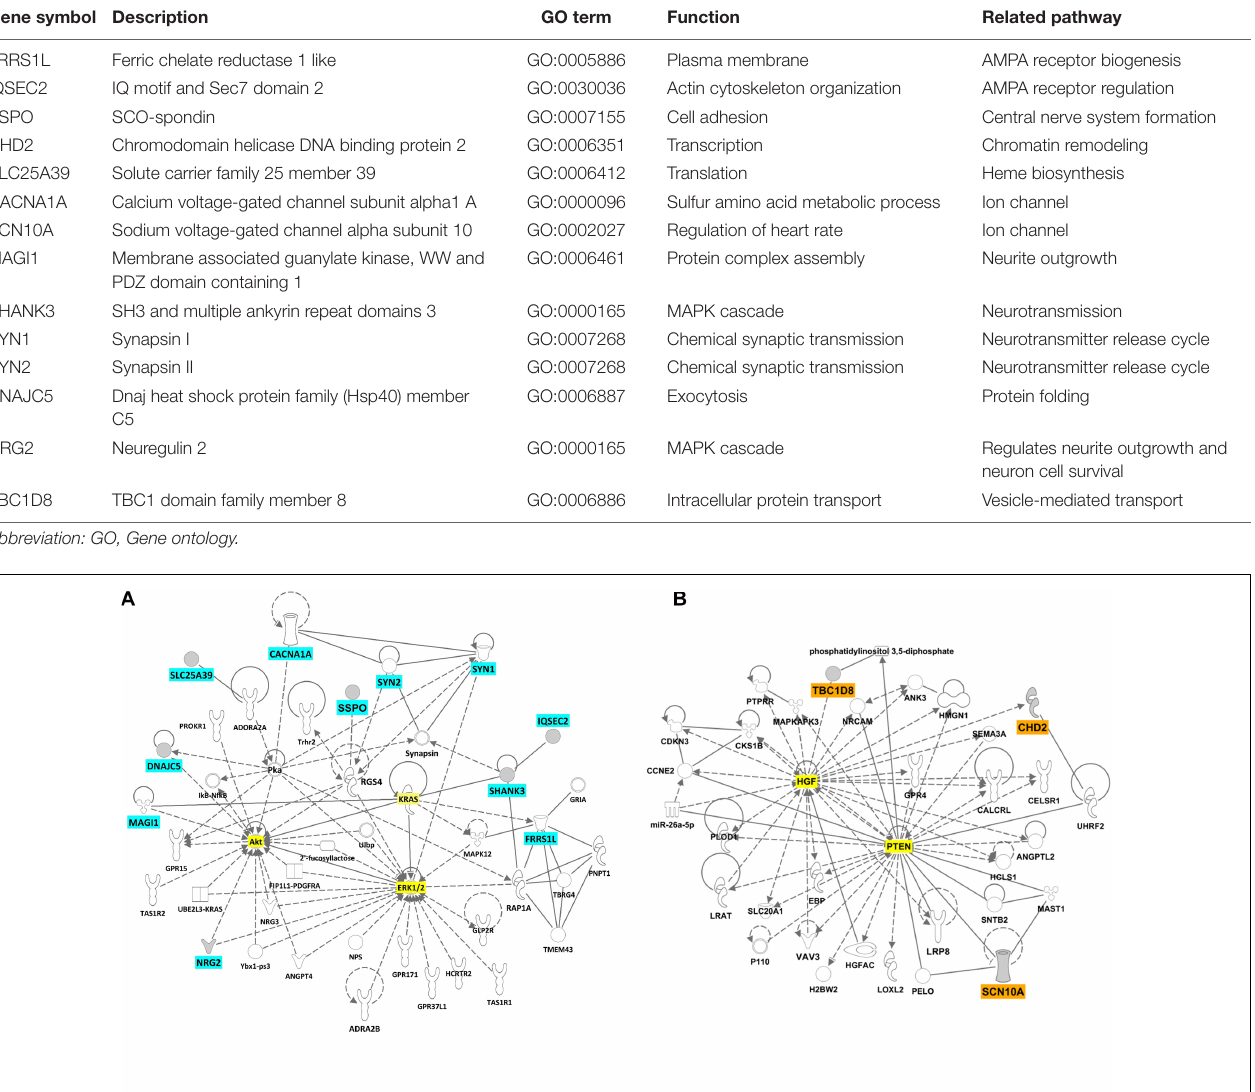
TABLE 3 | Gene ontology results of candidate genes of LGS or LGS-like epilepsy.